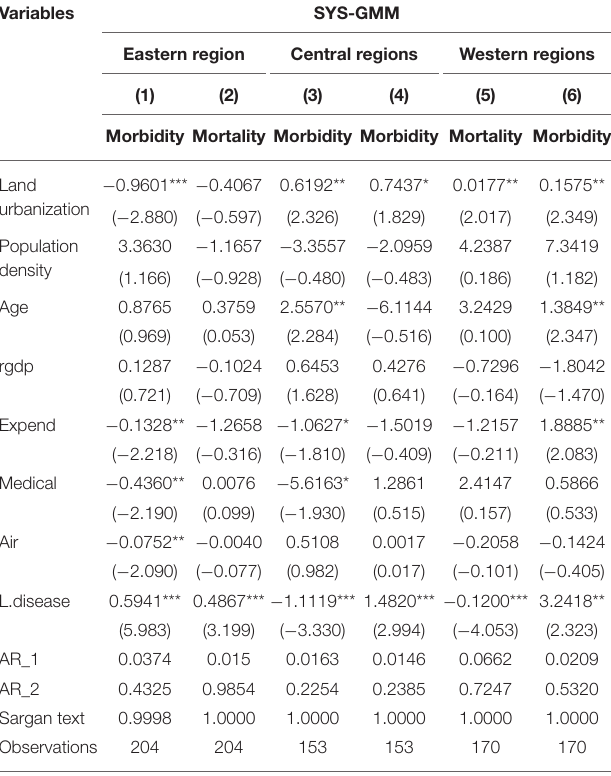
TABLE 4 | Regional differences in the impact of land urbanization.